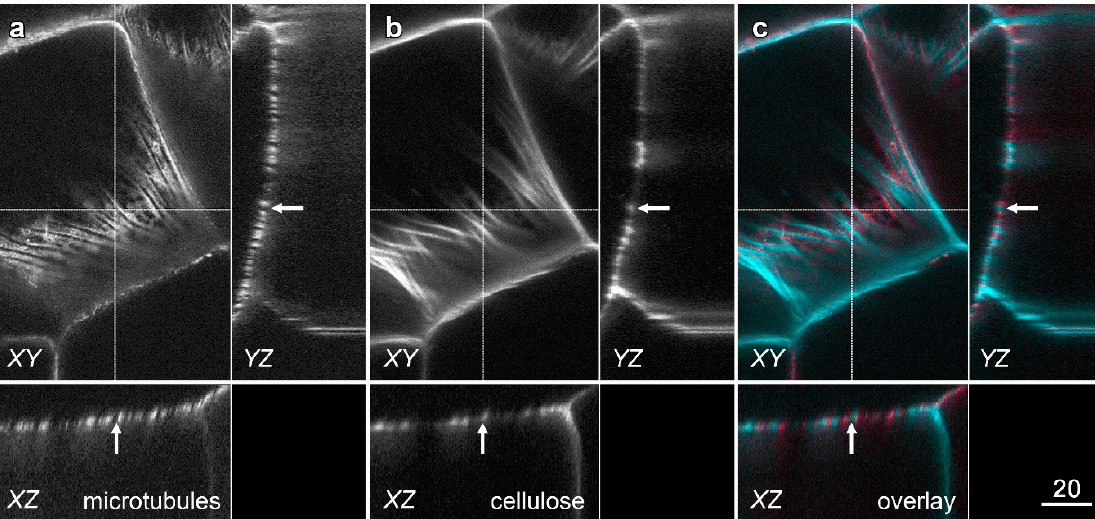
Figure 7. Split microtubule bands lie on either side but not underneath cell wall ridges. The microtubule splitting pattern in Miltoniopsis roots does not occur because of a change in focal plane of the microscope. Confocal optical sections were collected at 1 µm intervals through vibratome sections of inner velamen cells immunolabelled for ( a ) microtubules (coloured red in the overlay image) and ( b ) stained with pontamine for cellulose (coloured cyan in the overlay image). ( c ) Overlay image. Microtubules showed distinct patterns from the developing cellulose wall ridges. A single confocal optical section is shown (panels XY ) with YZ and XZ planes being computer-generated orthogonal reconstructions at the locations indicated with the dotted lines. These reconstructions show that late in velamen development, microtubules run on either side of the secondary cell wall ridge (arrows) rather than directly underneath them. Bar in ( c ) = 20 µm for all images.